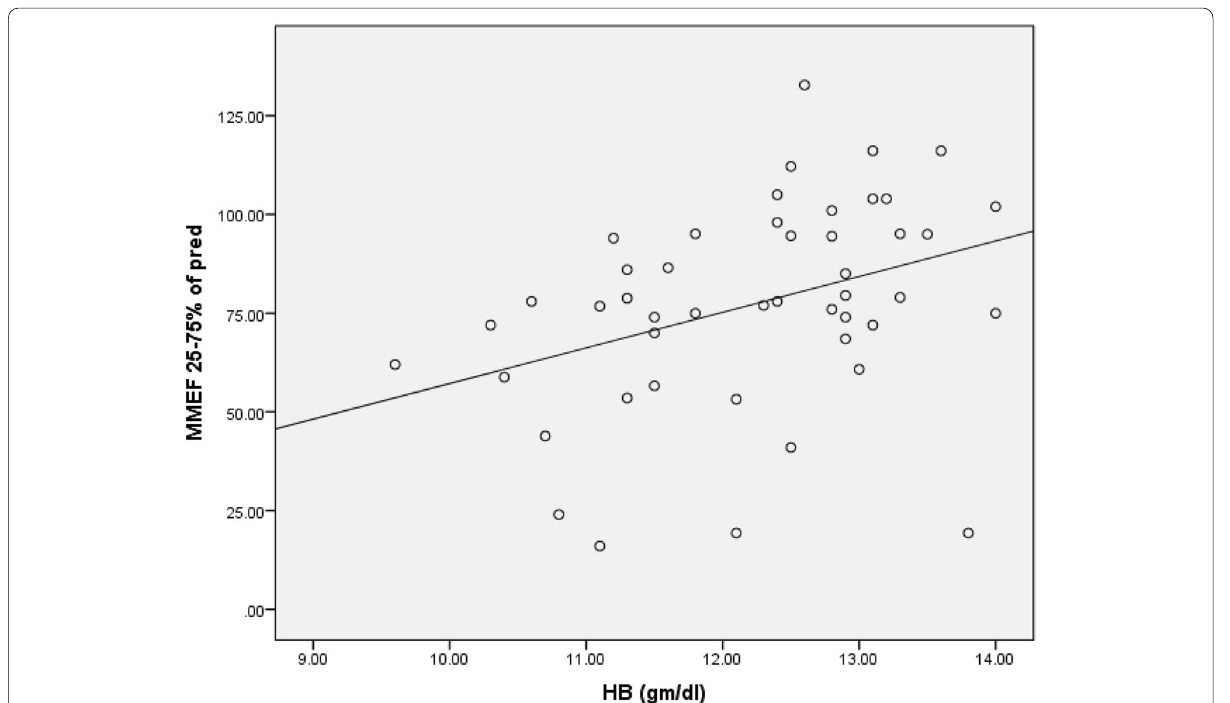
Fig. 1 A positive correlation between MMEF 25–75% and hemoglobin